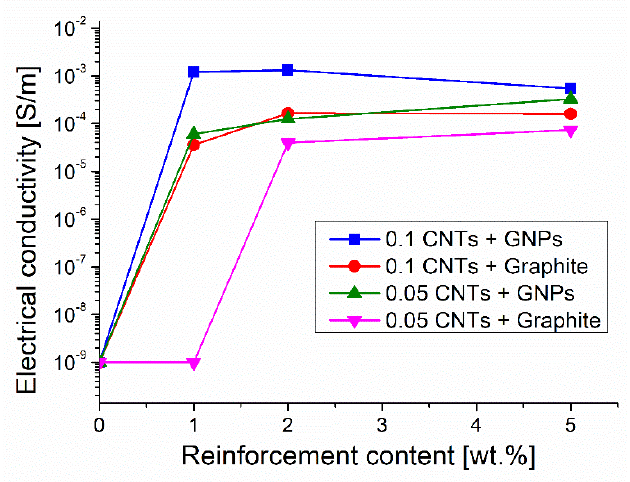
Figure 4. Synergetic e ff ect of filler combination on the electrical conductivity of hybrid composites .